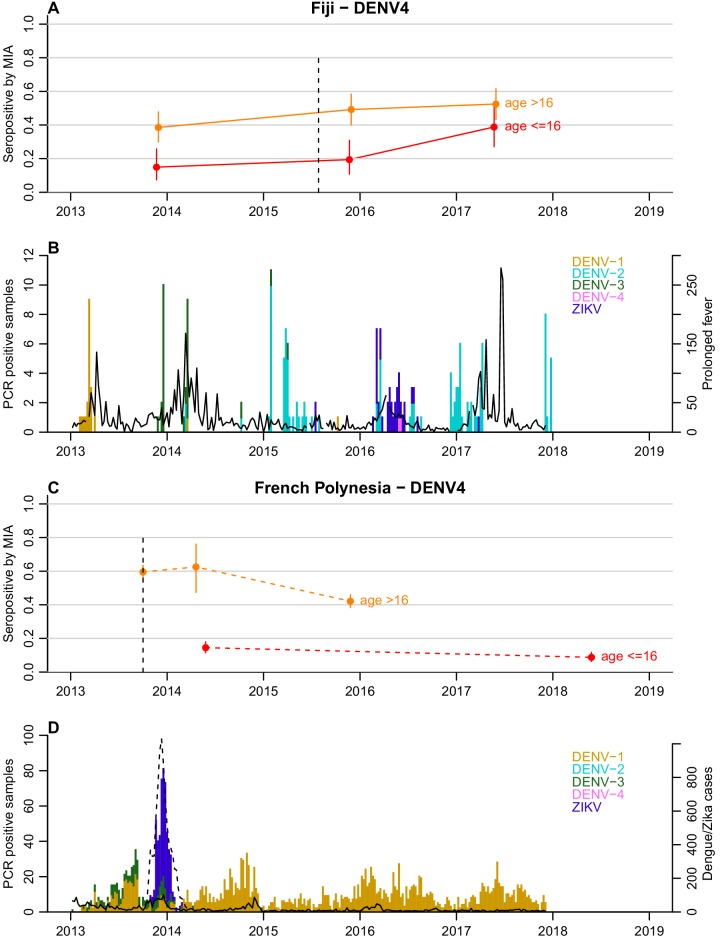
Seroprevalence against DENV-4 in Fiji and French Polynesia, by age group.Figure colour scheme and data characteristics are same as in Figure 1.